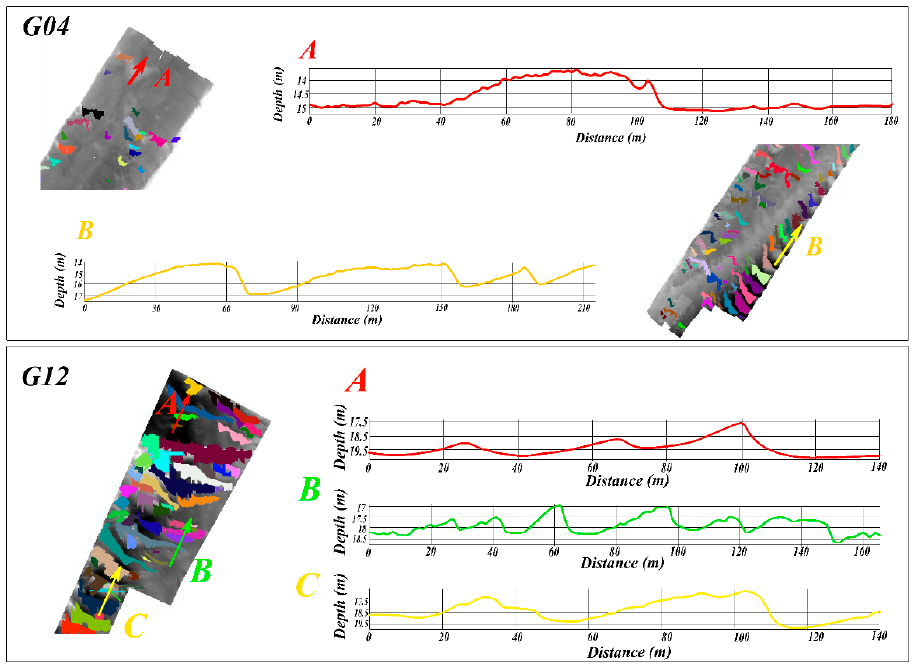
Figure 15. False positive dredged dunes segmented from surfaces G04 and G12. The arrows illustrate the profiles and their directions on the DBM.